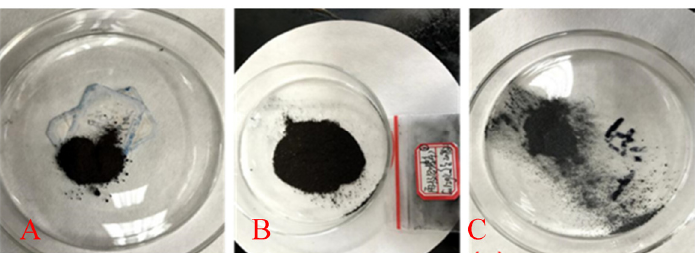
Figure 6. The cadmium matrix sample. ( A ) Acadmium matrix, ( B ) cadmium sponge matrix, and ( C ) deposited at the bottom of the cell and the suspended cadmium matrix.